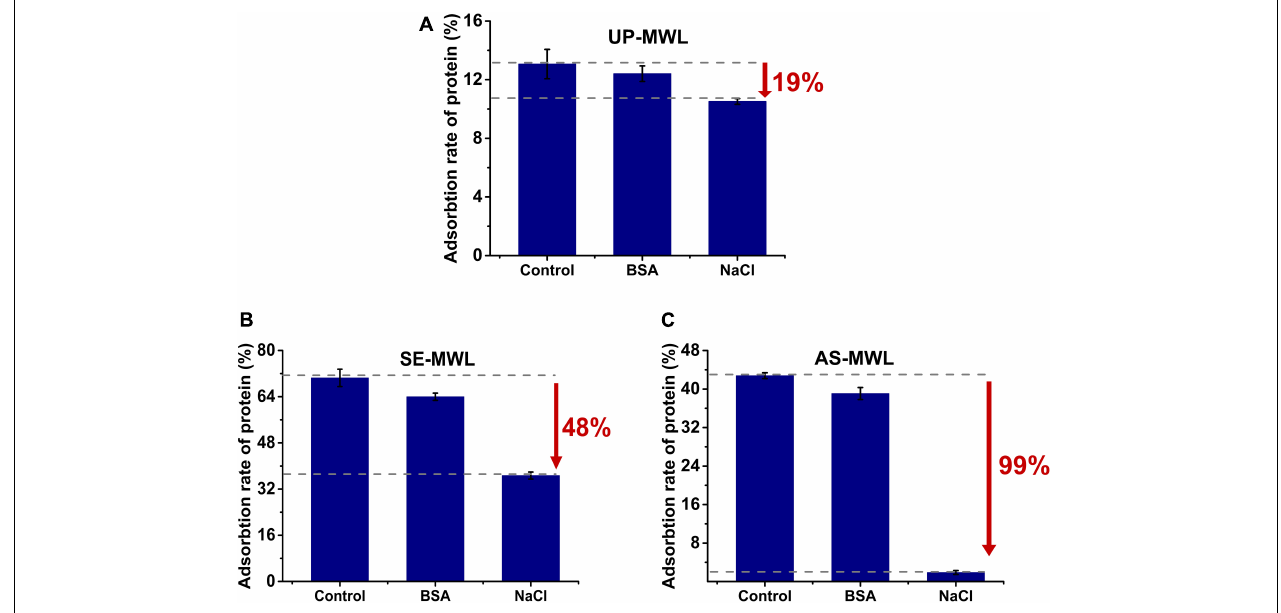
FIGURE 3 | Effect of adding NaCl or BSA to reaction system on the adsorption of Xyn10A onto different lignin samples, i.e. UP-MWL (A) , SE-MWL (B) , AS-MWL (C) , in which control is the sample without addition of NaCl and BSA. BSA, bovine serum